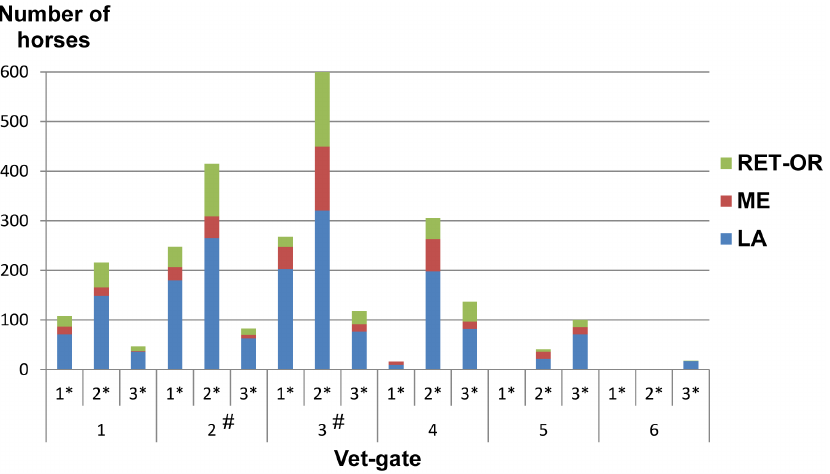
Fig 2. Distribution of the eliminated horses as a function of the cause of elimination, the vet gate and the event distance. 1 * : 80 – 119 km, 2 * : 120 – 139 km, 3 * : 140 – 160 km, LA: lameness, ME: metabolic reasons, RET: retirement, OR: other reasons. # indicates a significantly greater elimination rate for all distance categories.